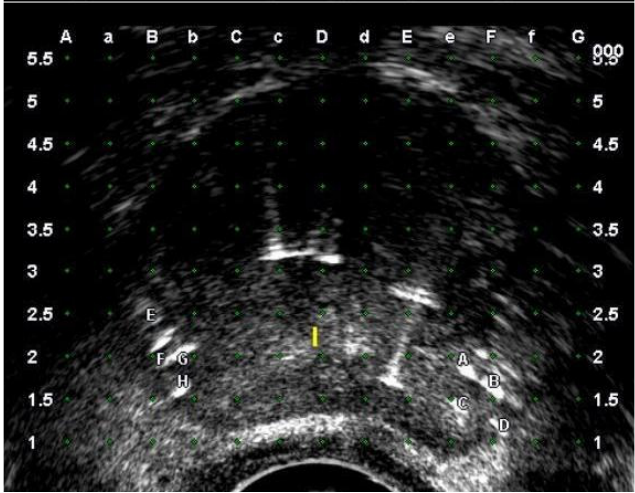
FIGURE 2. Axial transrectal ultrasound image of mid-prostate with fiberoptic fibers after positioning with stereotactic brachytherapy equipment for focal treatment. Fibers are labeled A–D in right lobe and E–H in left lobe. The urethra is indicated by a small vertical yellow line. Other echoic features